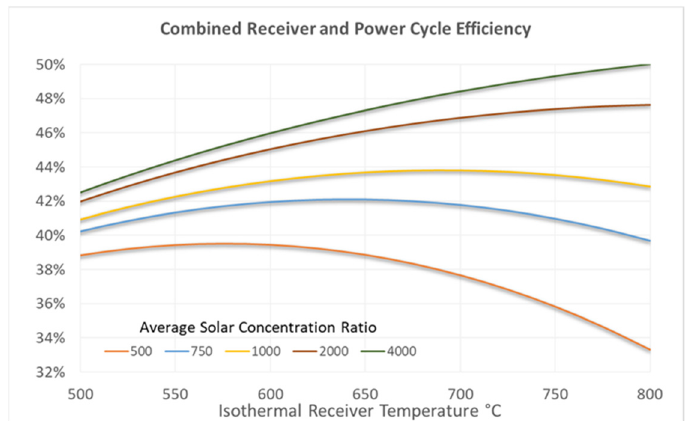
Figure 3. Instantaneous combined receiver and power cycle efficiency. The analysis assumes no convection losses. Solar absorptivity and black body emissivity are both set to unity. The entire receiver is assumed to be isothermal. The power cycle is assumed to have a temperature 50 °C less than the isothermal receiver temperature. The power cycle efficiency is assumed to be 75% of the Carnot limit at each temperature. The direct normal irradiance (DNI) on the heliostat field is assumed to be 750 W/m 2 and the optical field efficiency is assumed to be 55%.